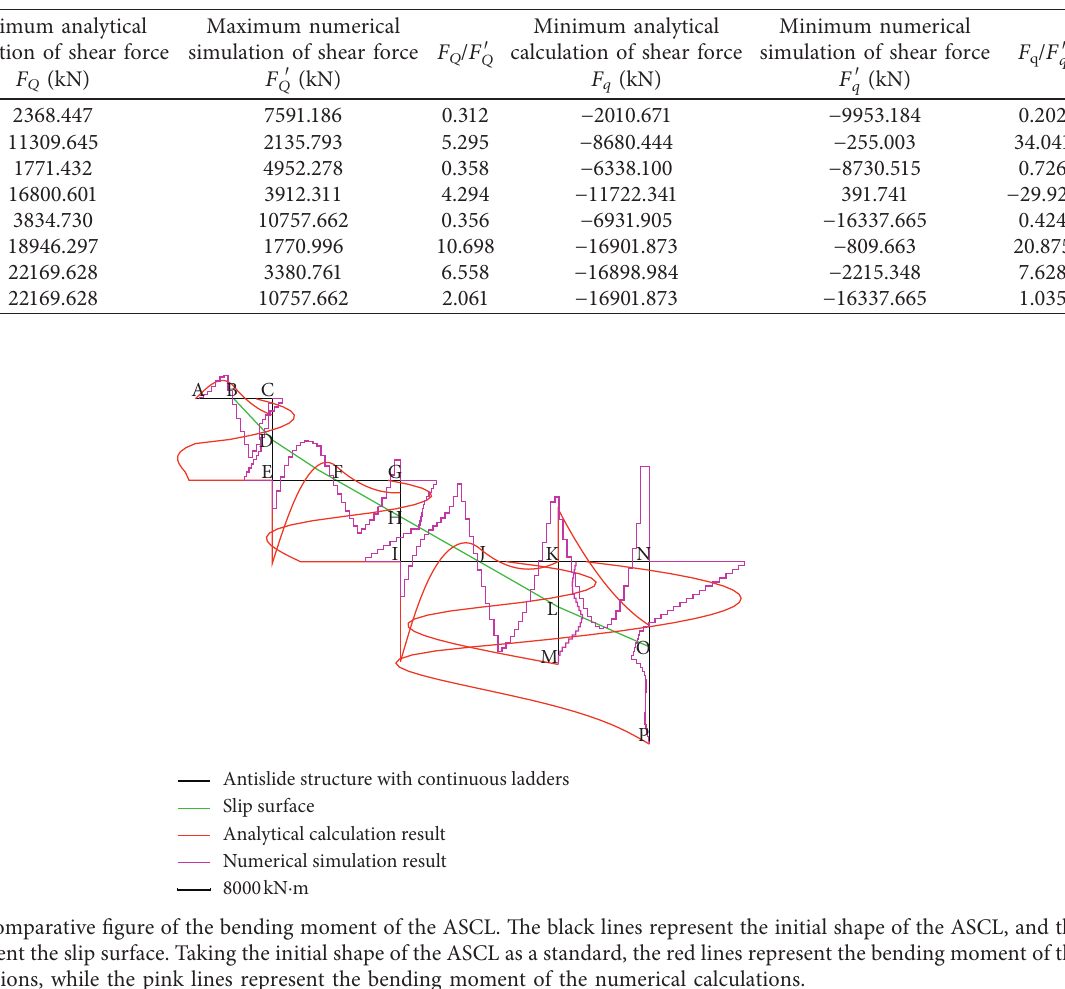
Table 6: A comparative table of the shear force of the antislide members.